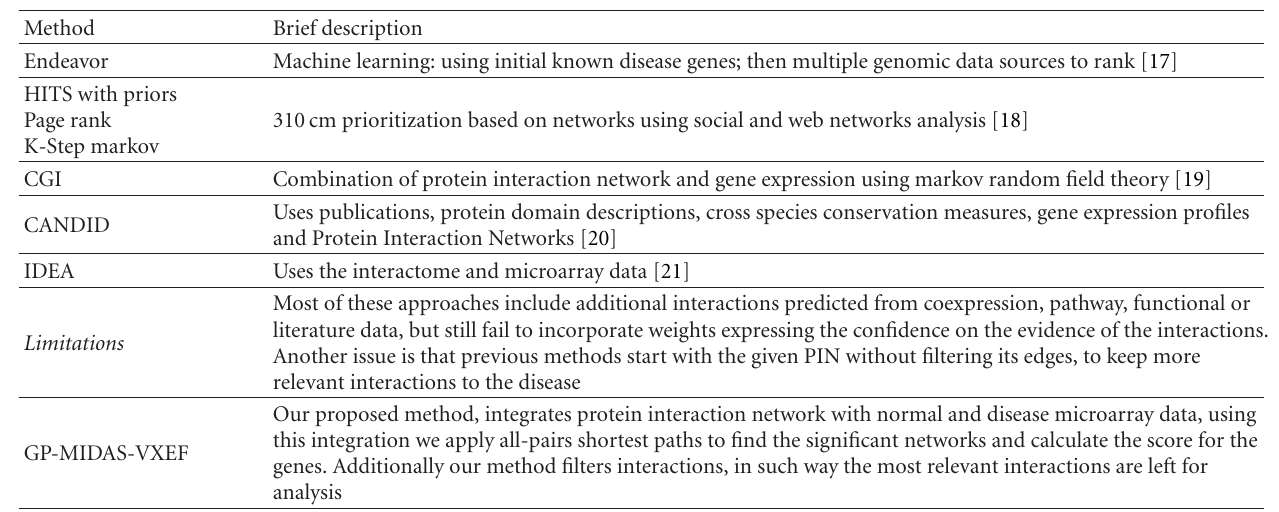
Table 7: Network based gene prioritization